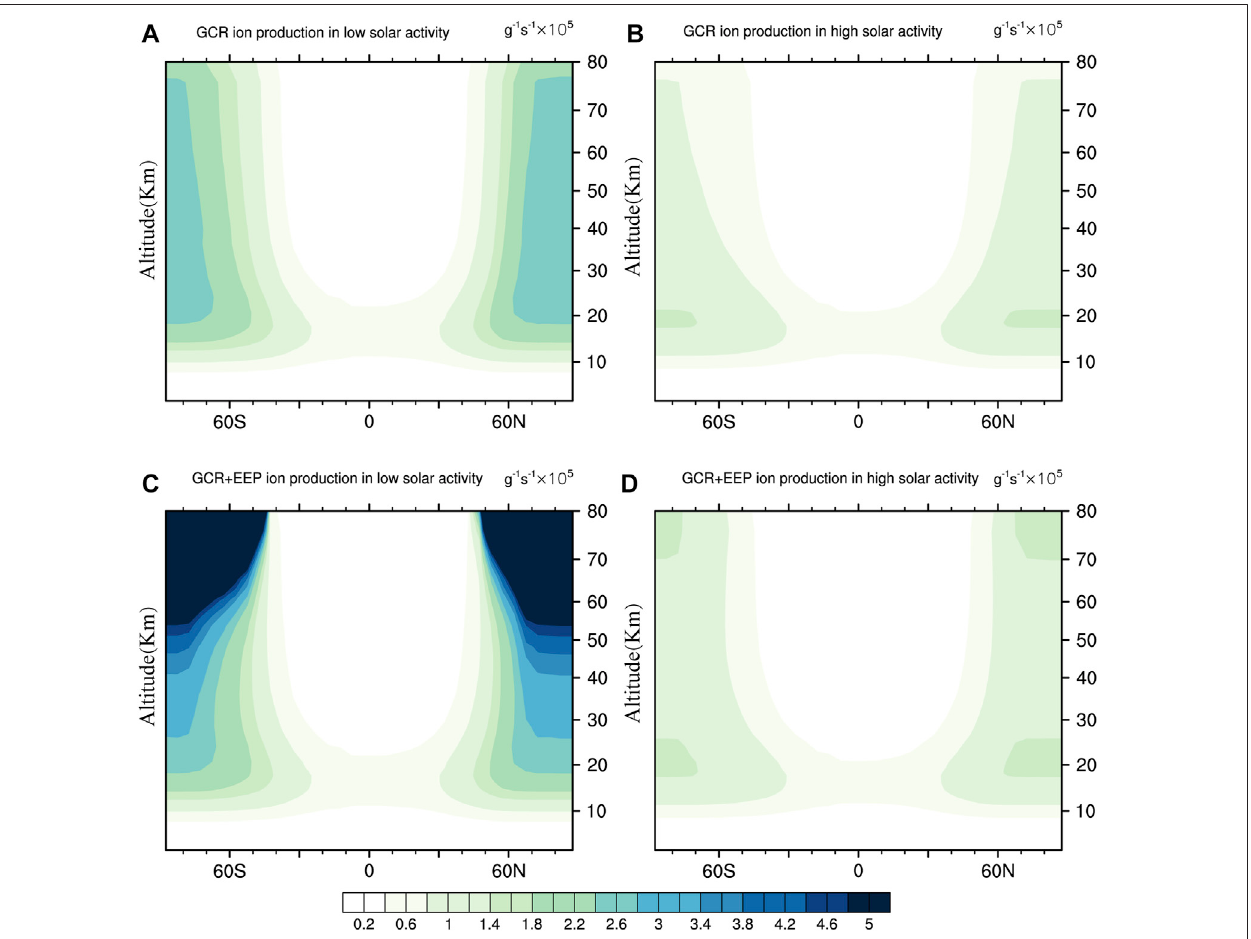
FIGURE 3 | The ion pair production rate due to GCRs and EEP. (A) shows the ion pair production rate due to GCRs during the solar minimum, (B) shows the ion pair production rate due to GCRs during the solar maximum, (C) shows the ion production rate due to GCRs + EEP during the solar minimum, and (D) shows the ion production rate due to GCRs + EEP during the solar